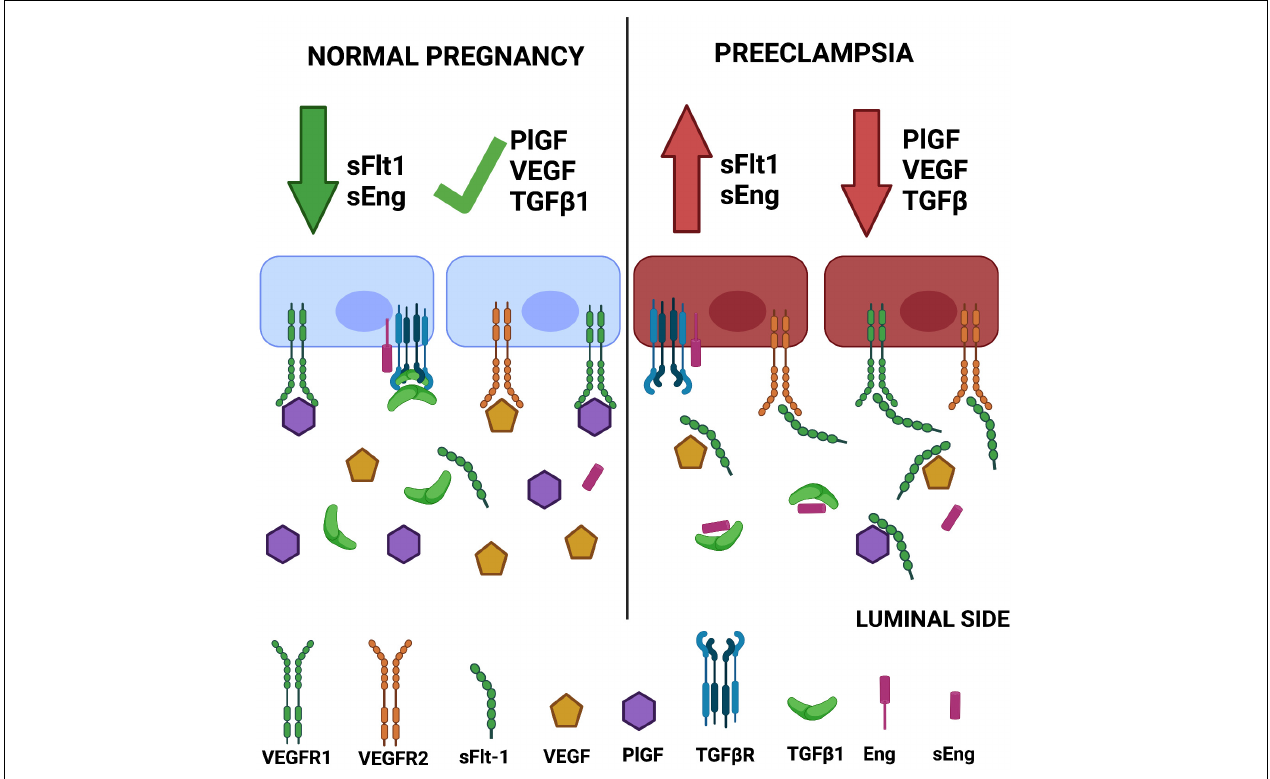
FIGURE 1 | Angiogenic imbalance in preeclampsia. The classic hypothesis of angiogenic imbalance proposes that circulating levels of soluble tyrosine kinase-1 similar to fms (sFlt-1) and soluble endoglin (sEng) are increased in preeclampsia, reducing the concentrations of free vascular endothelial growth factor (VEGF)/placental growth factor (PlGF) and TGF β , respectively. This outcome leads to endothelial dysfunction. Created with BioRender.com.